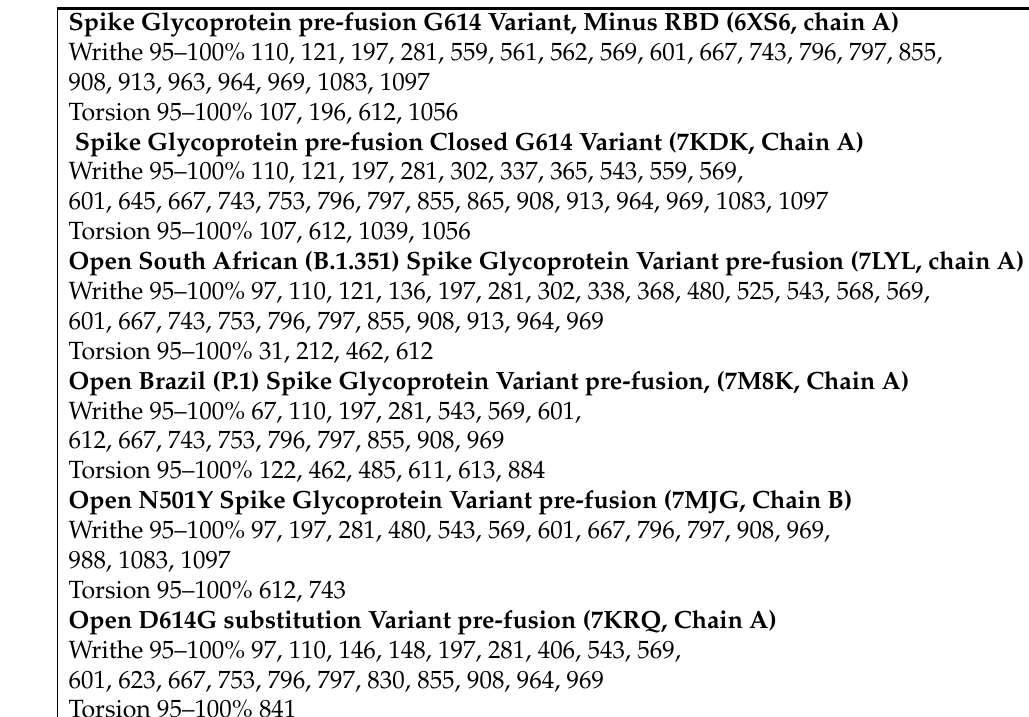
Table 2. High local topological free energy conformations of SARS-CoV-2